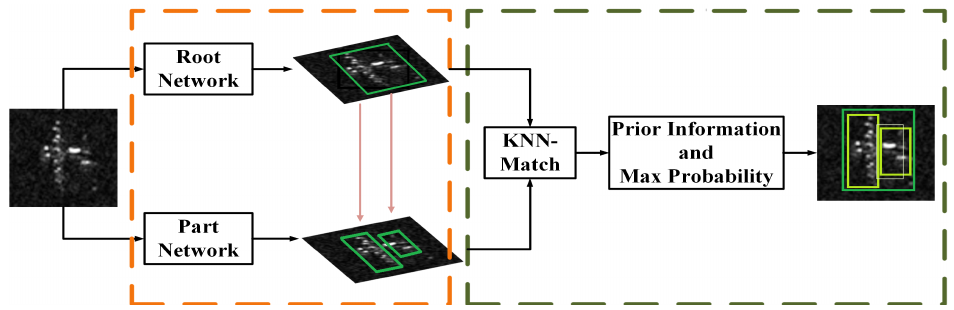
Figure 1. Framework of the component-based multi-layer parallel network for airplane